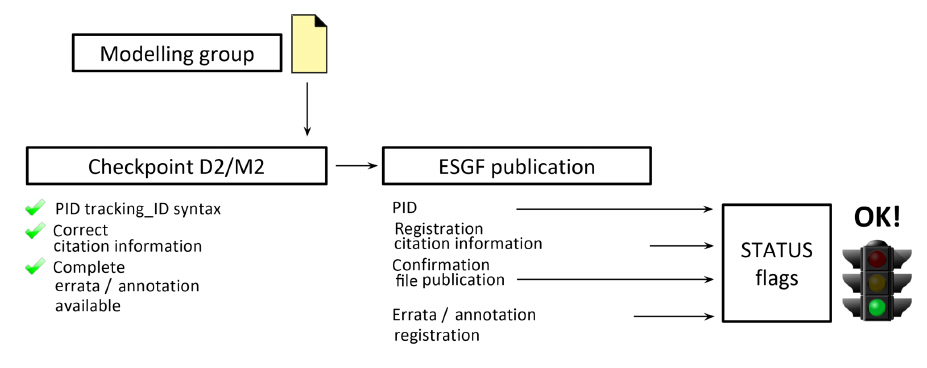
Figure 4. PID workflow, showing the generation and registry of PIDs, with checkpoints where compliance is